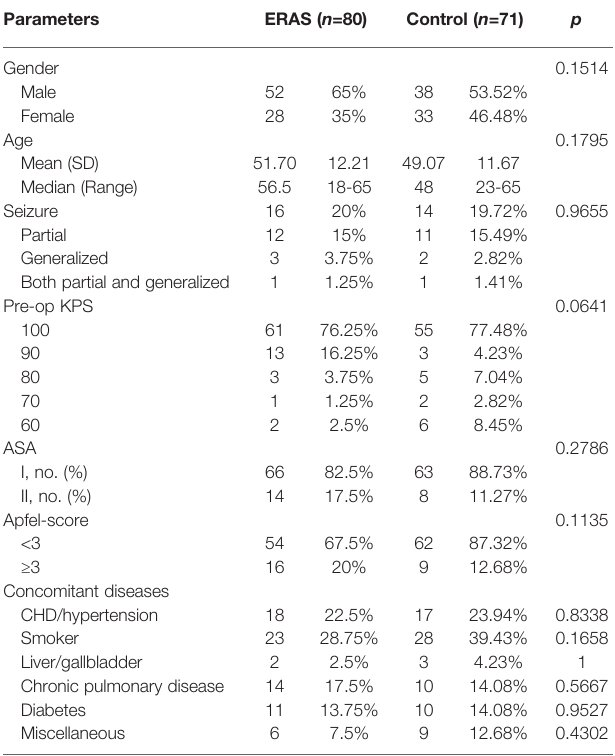
TABLE 1 | The demographic characteristics of patients with gliomas in two groups. Parameters